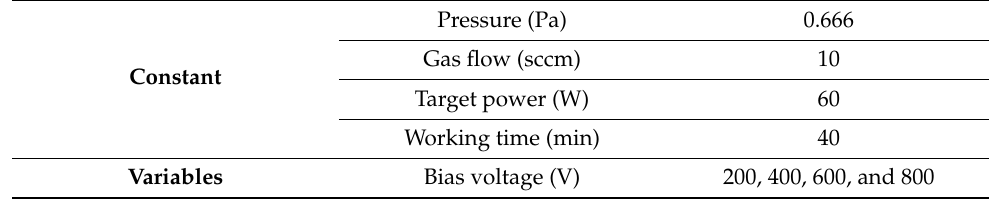
Table 2. Experimental conditions for Nb